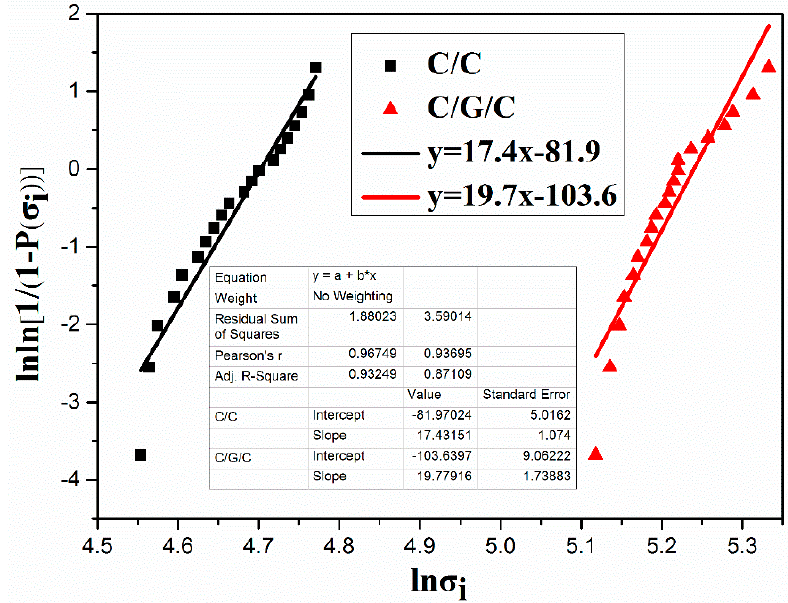
Figure 9. Weibull plots of the flexural strength of the C/C and C/G/C composites.